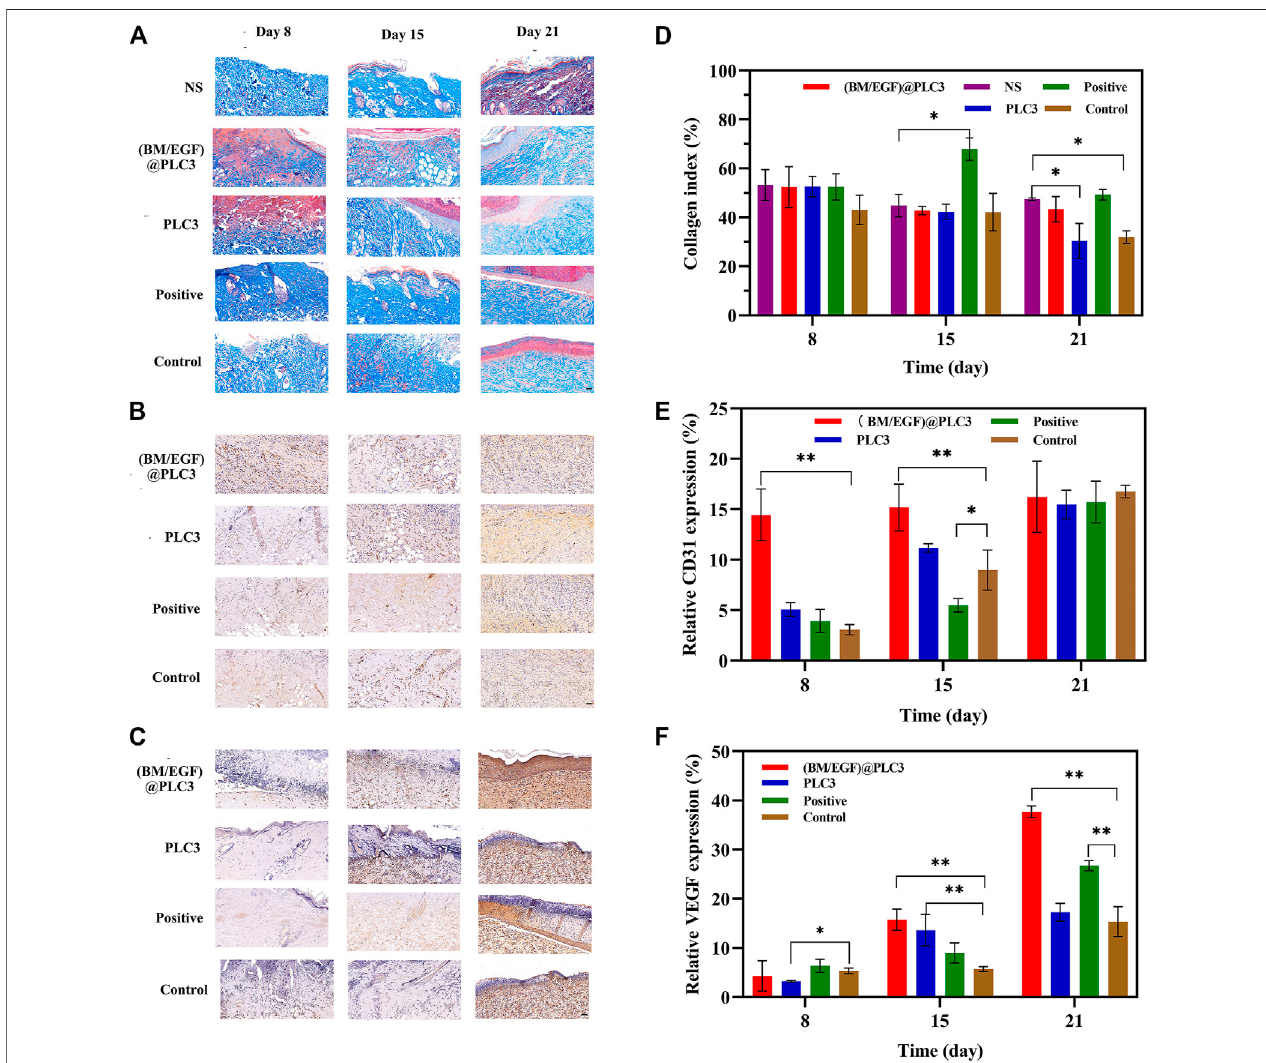
FIGURE8| Theresultofquantitativedetection. (A) Masson ’ strichromestaining, (B) CD31Staining,and (C) VEGFstainingofsampledtissueondays8,15,and21 before treatment. Quantitative detection for (D) collagen, (E) CD31, and (F) VEGF of sampled tissue. With the data shown as means ± SD ( n (cid:1) 3, * p < 0.05, ** p < 0.01), scale bar: 50